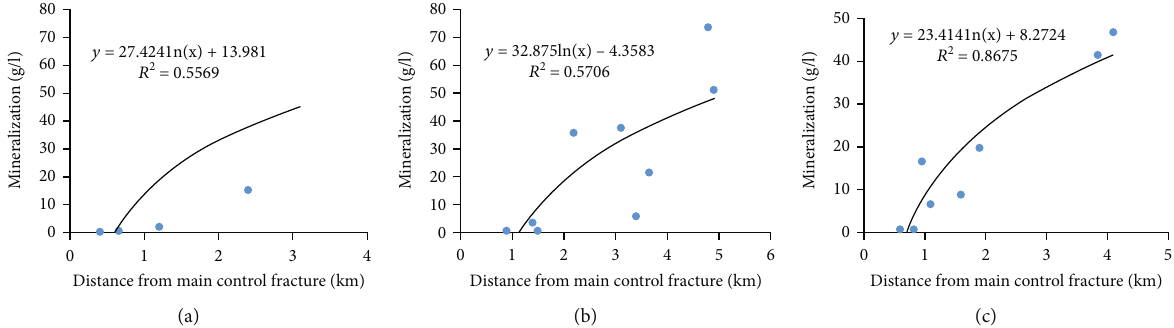
Figure 7: Relationship between the formation water mineralization values of key wells in the southwestern Sichuan Basin and the distance from the dominating fault. (a) Cambrian. (b) Upper Permian. (c) Triassic.